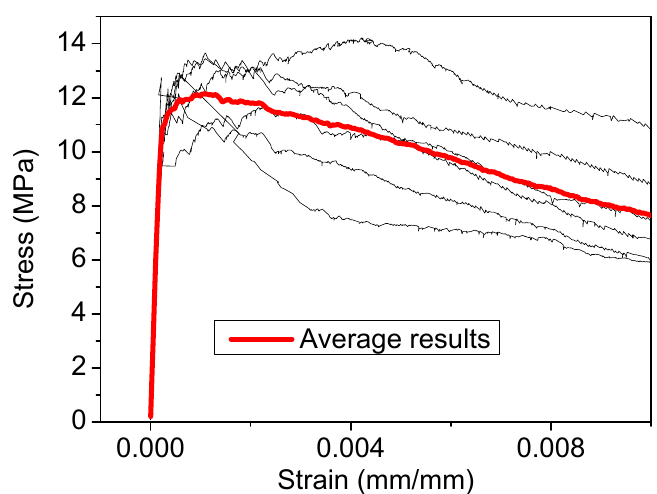
Figure 8. Direct tensile stress (MPa)–strain (mm/mm) results for UHPFRC-2.